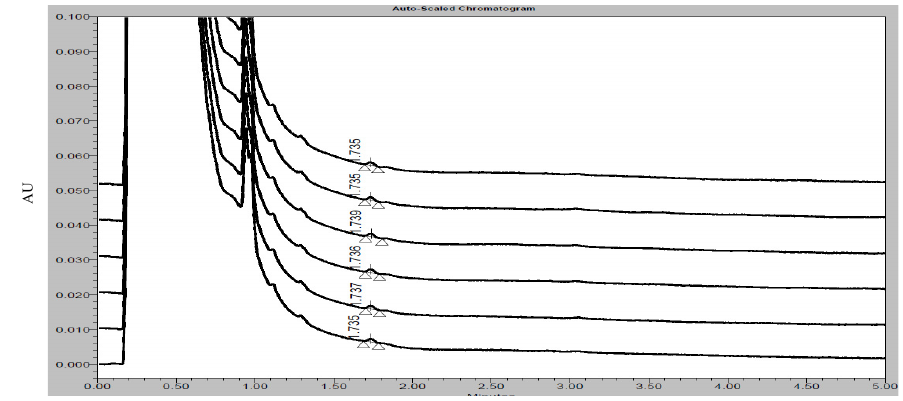
Figure 5. Overlay chromatograms of precision at LOQ level